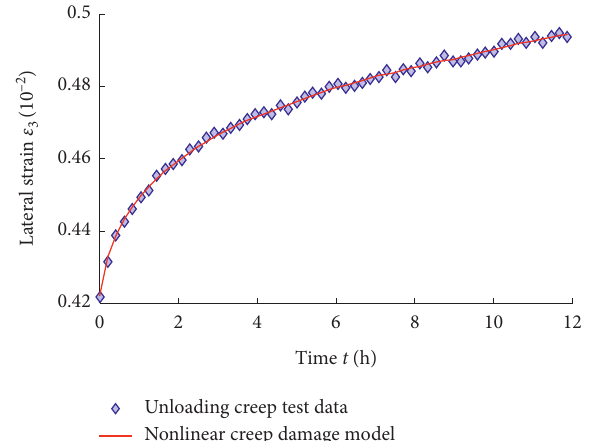
Figure 16: Fitting curve of constant axial pressure unloading of confining pressure and nonlinear creep constitutive